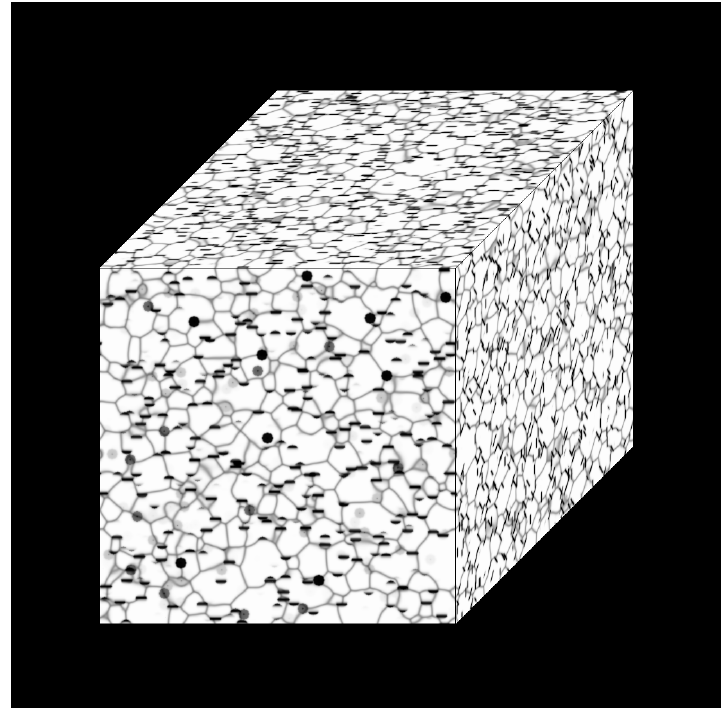
Figure 4. Grain structure with 3 vol% volume fraction at 14,000 ∆ t . The hydrides are aligned along three directions (three crystallographic variants), and the portions of each variant are equal. The system contains 3669 grains, and the average grain radius is 15.246. The volume of every hydride is the